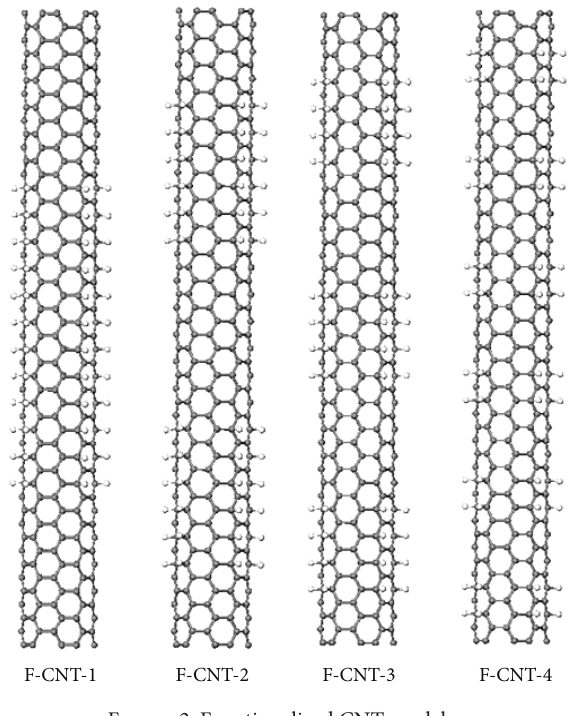
Figure 2: Functionalized CNT models.